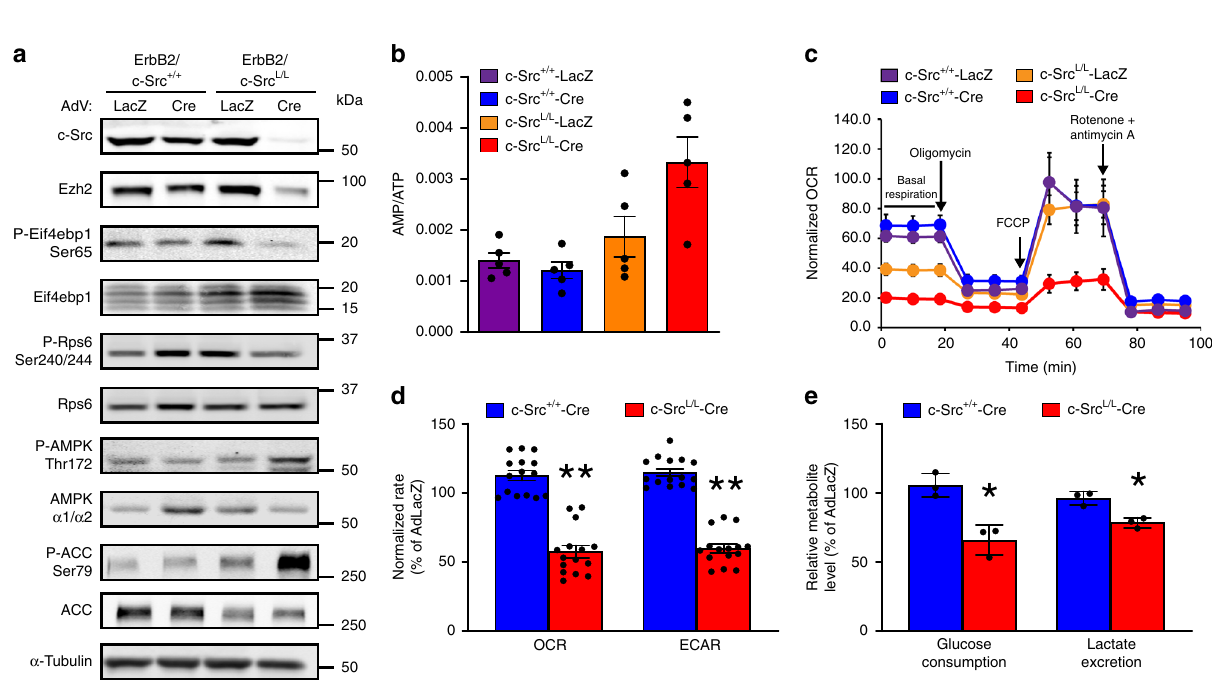
Fig. 6 Acute c-Src ablation diminishes both OXPHOS and glycolysis. a ErbB2 + murine breast cancer cells with wild-type ( c-Src + / + ) or conditional ( c-Src L/L ) Src alleles were infected with adenoviruses bearing Cre recombinase or LacZ. Immunoblots show c-Src expression, mTORC1 and AMPK signaling and PRC2 component expression at 96 h post-infection. Data are representative of 3 cell lines per genotype. b LC/MS analysis of AMP:ATP ratios in control (LacZ) and Cre-expressing cell lines ( n = 3 cell lines per genotype). c Basal, maximal (FCCP), ATP-synthesis-coupled (Oligomycin A), and non- mitochondrial (rotenone/antimycin A) oxygen consumption rates (OCRs) of ErbB2-expressing c-Src + / + and c-Src L/L breast cancer cell lines (n = 2 per genotype) infected with Cre or LacZ adenoviruses. Representative of 2 cell lines per genotype. d Basal OCR and ECAR of c-Src + / + and c-Src L/L cell lines infected with Cre adenoviruses, expressed as a percentage of the rate measured in the LacZ control for each cell line. e Glucose consumption and lactate levels in conditioned media from c-Src + / + and c-Src L/L cell lines infected with Cre adenoviruses, expressed as a percentage of levels observed in LacZ- expressing controls. All bar charts show mean ±SEM, with * = p < 0.05 and ** = p < 0.01 (unpaired, two-tailed Student ’ s t